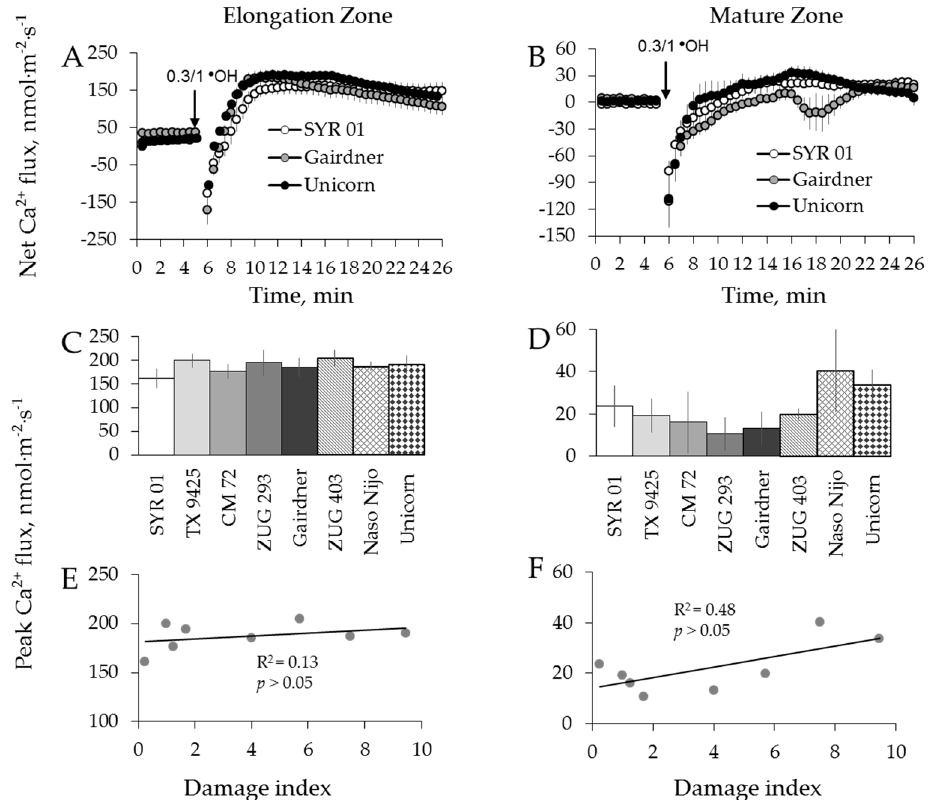
Figure 9. Kinetics of Ca 2+ fluxes from three representative barley varieties in response to 0.3/1 mM Cu 2+ /ascorbate mixture ( ● OH) treatment from both root elongation zone ( A ) and mature zone ( B ). Error bars are means ± SE ( n = 6–8). ( C , E ) Peak Ca 2+ fluxes ( C ) of eight barley varieties in response to ● OH and their correlation with damage index ( E ) in root elongation zone. ( D , F ) Peak Ca 2+ fluxes ( D ) of eight barley varieties in response to ● OH and their correlation with damage index ( F ) in root mature zone.